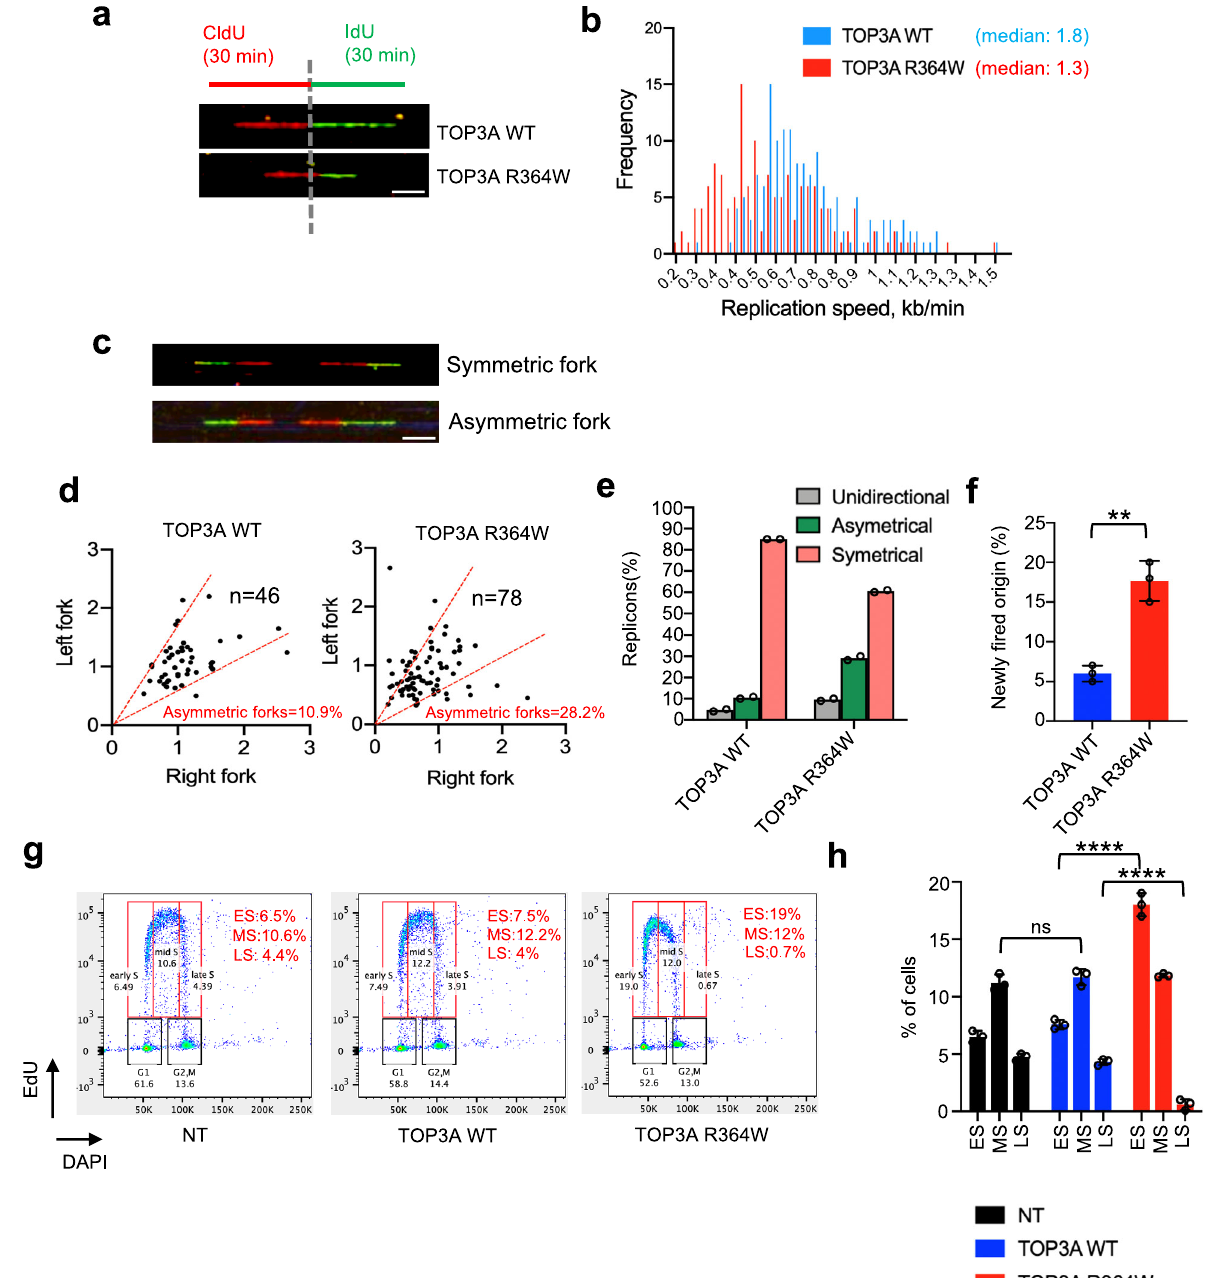
Fig. 3 | Trapped TOP3Accs alter DNA replication. a Schematic representation of the DNA combing assay protocol and representative single molecule images. NascentDNAwaslabeledwithCldU(30min)followedbyIdU(30min)inU2OScells transfected with TOP3A-WT and TOP3A- R338W. Scale bars: 100 μ m. b Histogram showing reduced replication fork speed in U2OS cells expressing R364W-TOP3A. c Representative images of a symmetric and an asymmetric replicon observed in DNA combing. Scale bars: 100 μ m. d Self-trapping TOP3A-R364W induces asym- metric replication forks in U2OS cells. The values of x and y axis represent repli- cationspeed(kb/min) of the right fork and left fork, respectively. The percentages of asymmetric forks from the indicated cells are indicated in red. n =number of forksanalyzed.Asymmetricforkswereclassi fi edasthoseforkswhenthedifference between length of left forks and right forks emerging from the same origin was greater than 30%. e Histogram showing the percentages of unidirectional (grey), asymmetrical (green) and symmetrical (pink) forks in the indicated cell lines.